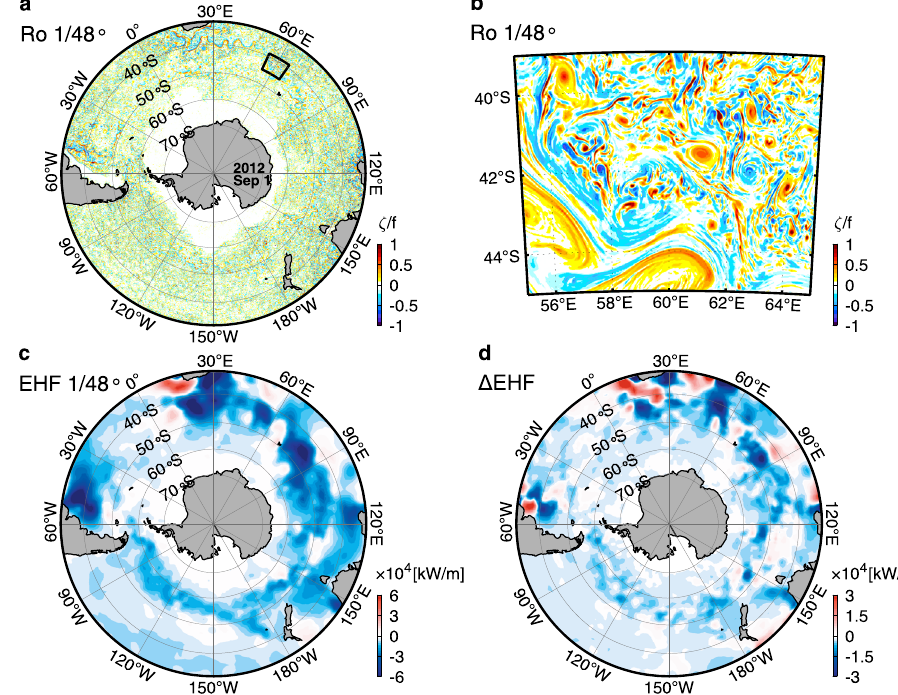
Fig. 1 | Distributions of Rossby number and eddy heat fl ux in the Southern Ocean.a SurfaceRossbynumberon1September2012calculatedusingtherelative vorticitydividedbytheplanetaryvorticity. b Zoominontheblacksquarein a .The distribution of Rossby number suggests that the Southern Oceanisabundant with bothmesoscaleandsubmesoscaleddies. c Verticallyintegratedtotaleddyheat fl ux (EHF) in the upper-1000m averaged over the simulation period (positive for